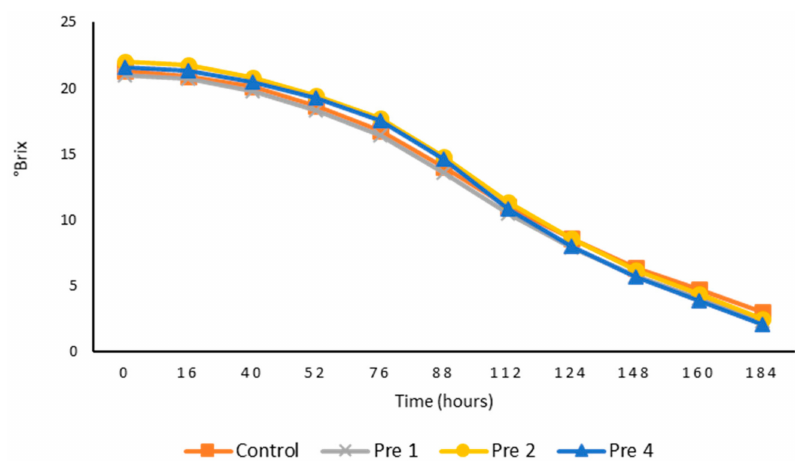
Figure 1. Comparative mean ◦ Brix values of triplicate, larger-scale 28 L ferments of control juice and juice with di ff erent GL